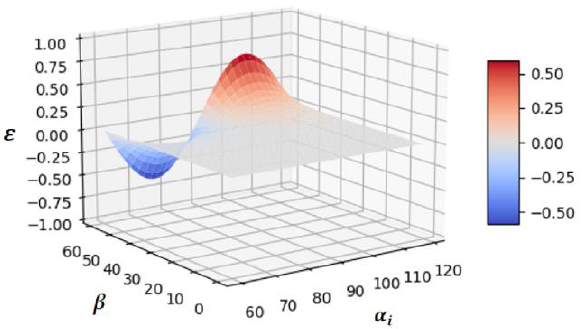
Figure 16. The theoretical perspective error analysis of the proposed method.